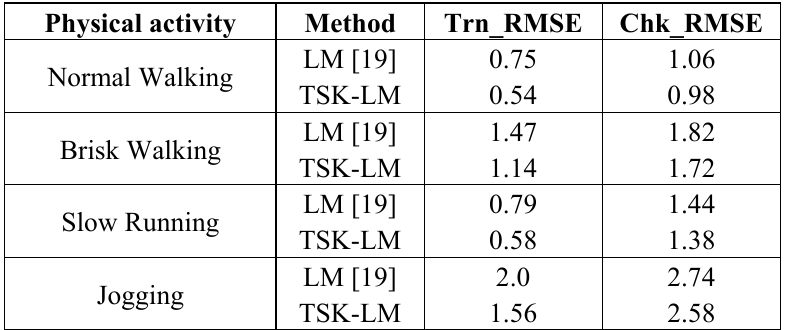
Table 4. Performance comparison of RMSE